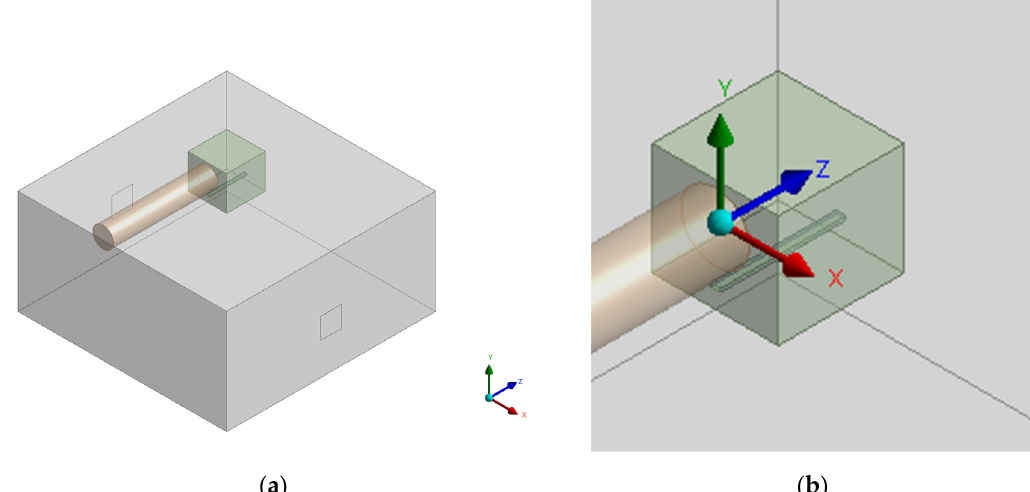
Figure 4. The computational domain used in the verification of mathematical and numerical models ( a ) domain withmodeled surrounding; ( b ) the plenum box with coordinate system.